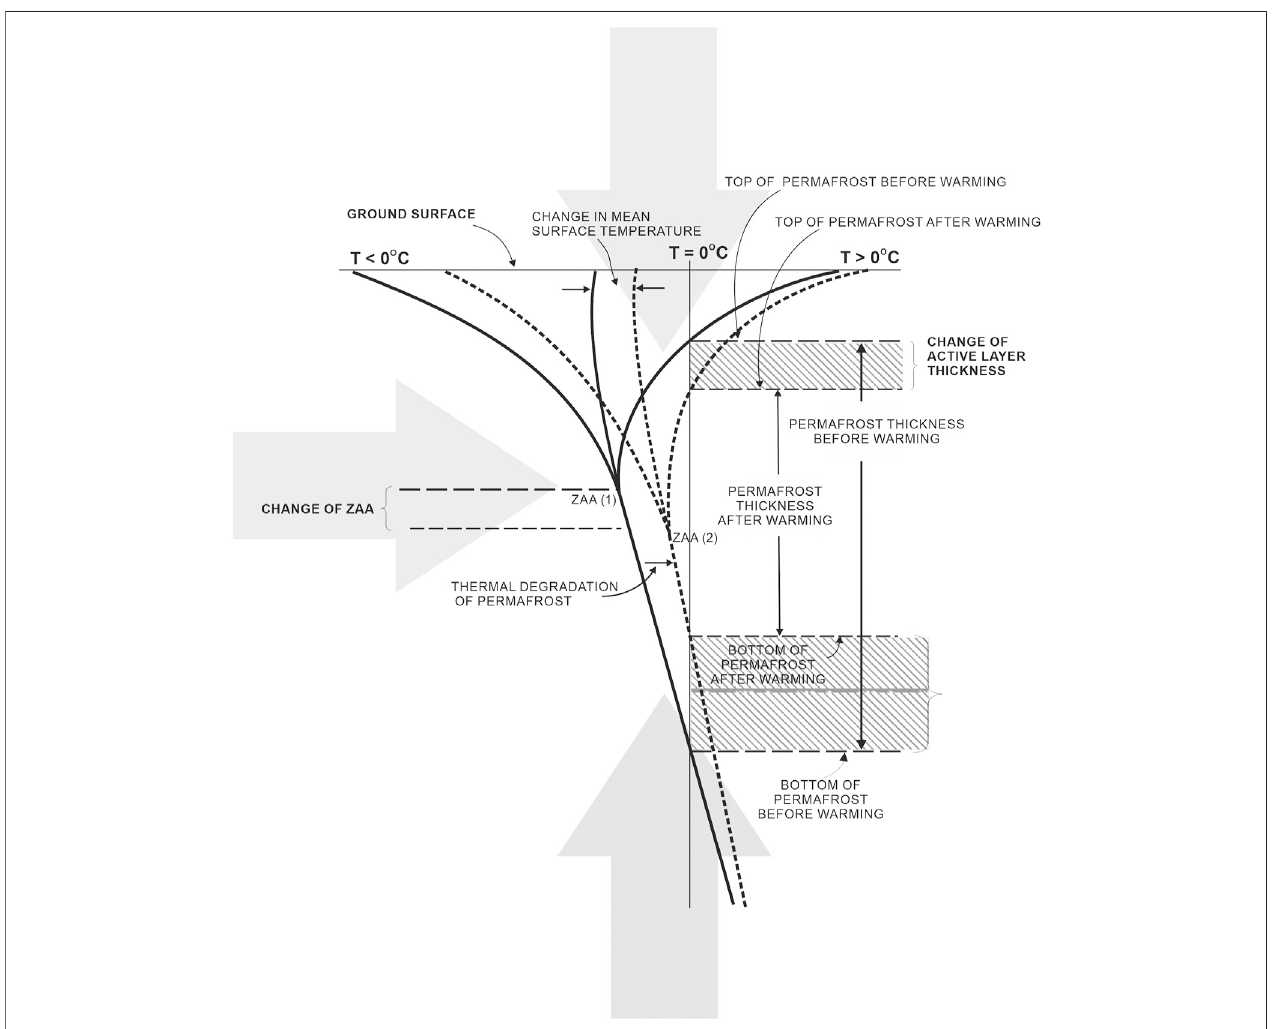
FIGURE 1 | General characteristics of permafrost degradation. When a heat wave passes through the entire permafrost layer, it warms the permafrost layer up throughout the entire pro fi le, causing the permafrost table to lower, the ZAA temperature to rise, and the permafrost base to rise.